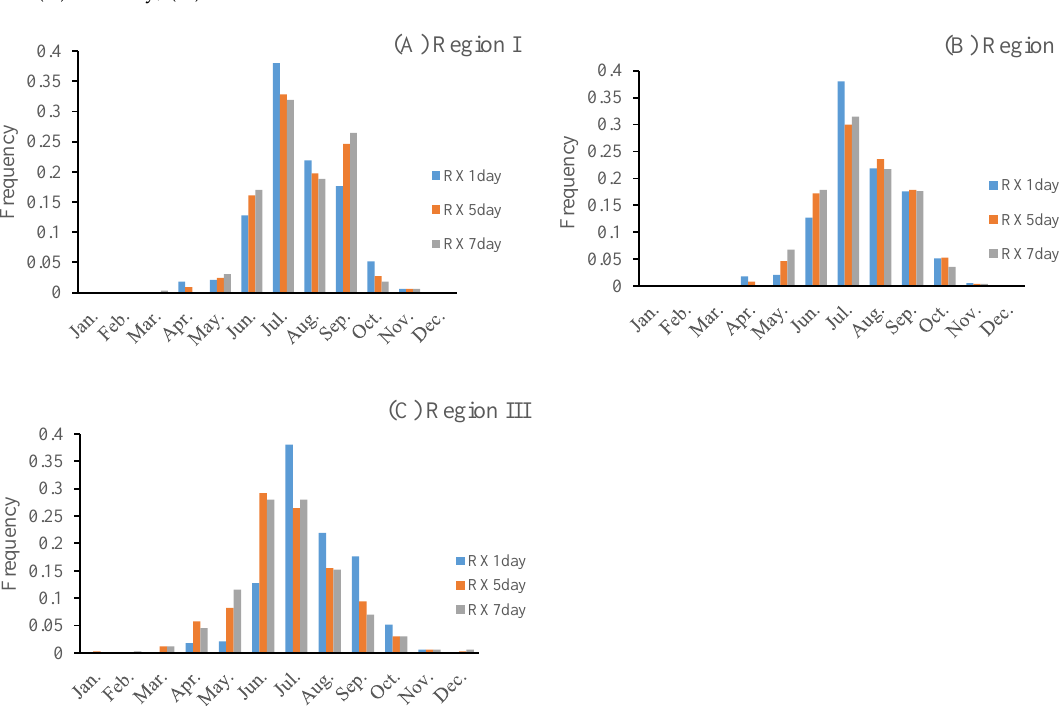
Figure 9. Seasonality of precipitation extremes in the three typical HOM regions.